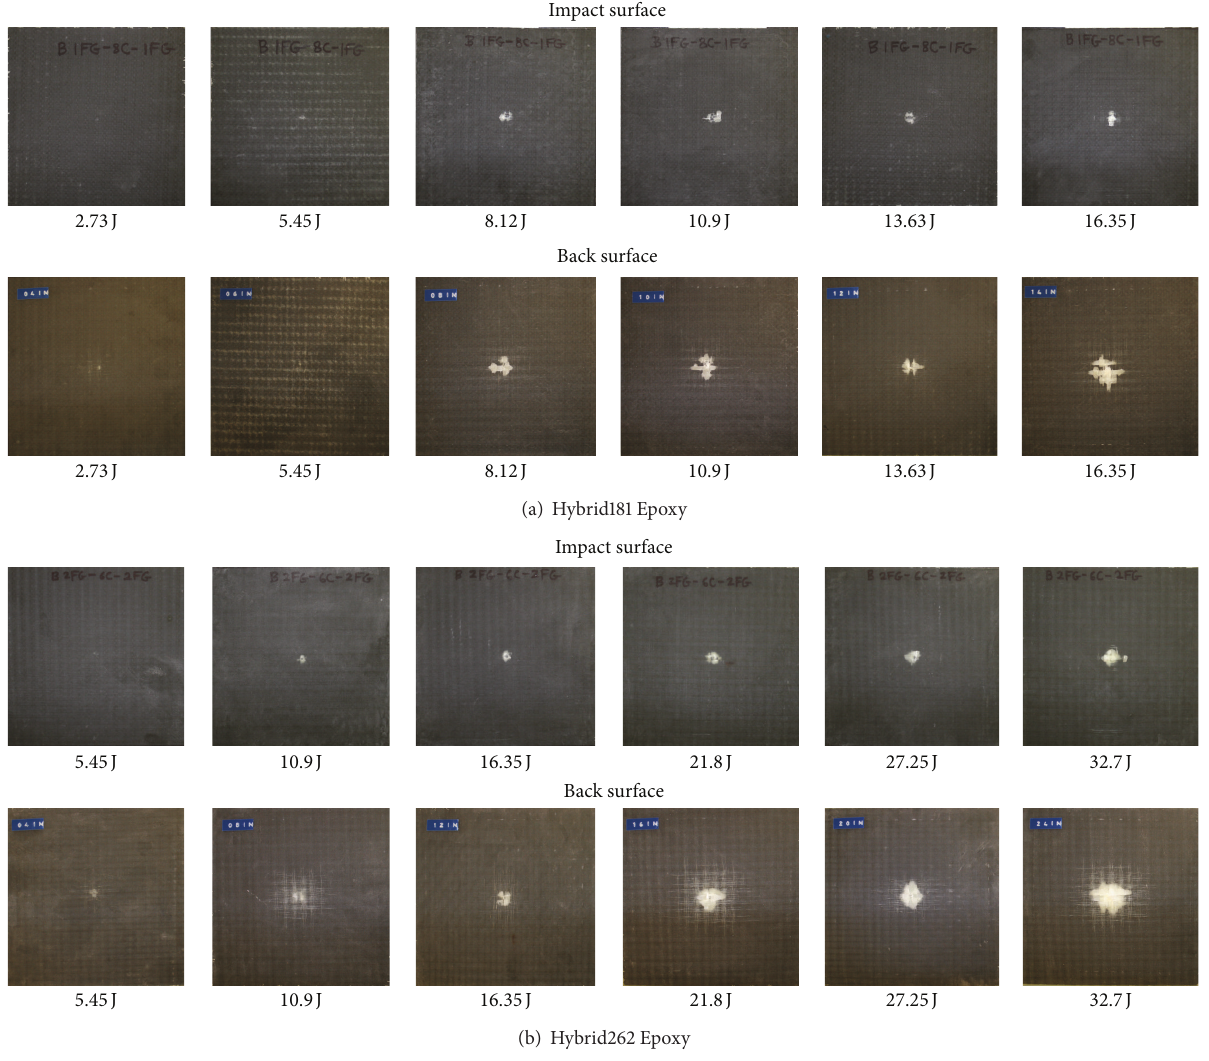
Figure 7: Progressive damage in Hybrid181 and Hybrid262